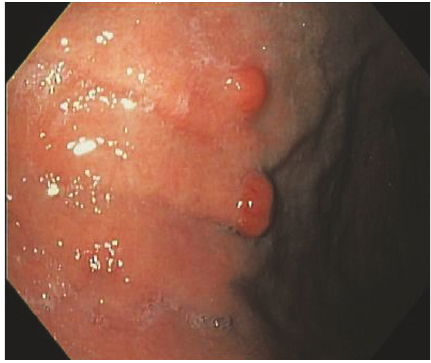
Figure 7: EGD showing two firm sessile